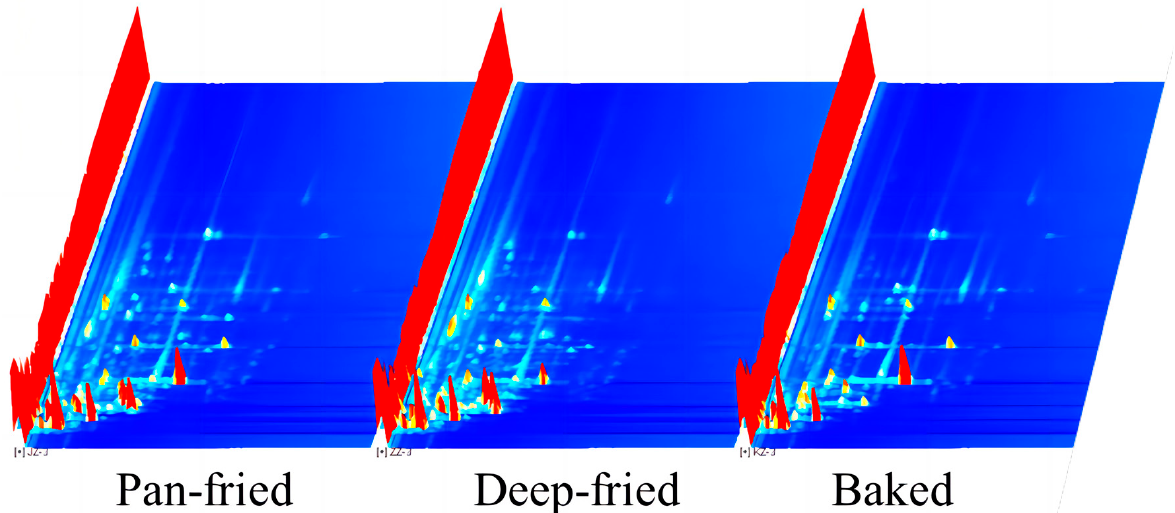
Figure 4. 3D topographic map of BTS meat processed by different high-temperature cooking